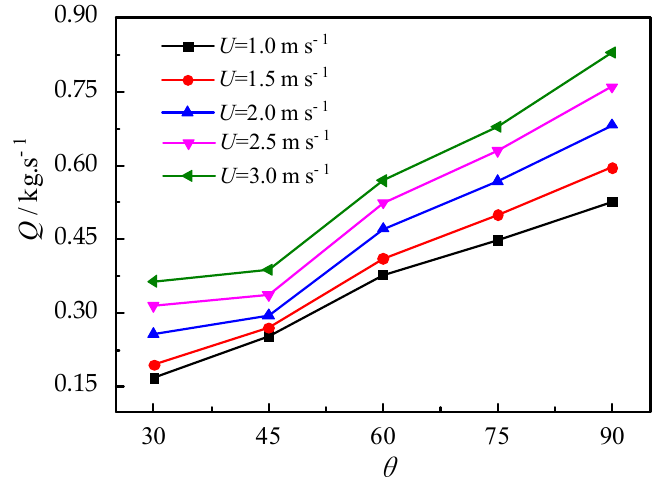
Figure 7. Variations of ventilation rate with the angle of inclination ( I = 600 W·m −2